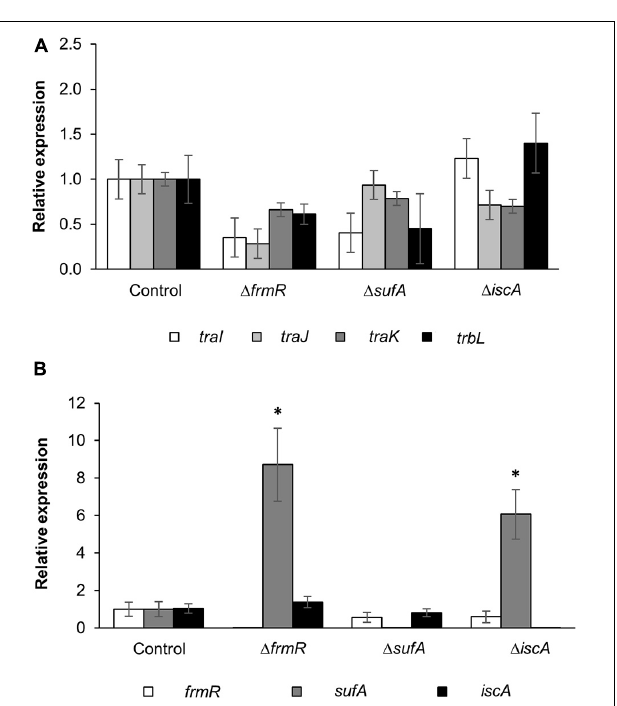
FIGURE 3 | Expression analysis of conjugation-related and up-mutant genes by qRT-PCR. (A) Expression of traI , traJ , traK , and trbL genes within the helper plasmid, IncP1 α -pRH220, harbored in the up-mutants and wild-type control donor strains, within triplicate experiments ( n = 3). (B) Expression of frmR , sufA , and iscA genes within the up-mutant and wild-type control donor strains, within six experimental replicates ( n = 6). Data are presented as mean ± standard error of the mean (SEM). Asterisk ( ∗ ) indicates statistically significant differences at p < 0.05 (two-tailed t -test) compared to wild-type control. BW25113 parental strain was used as the